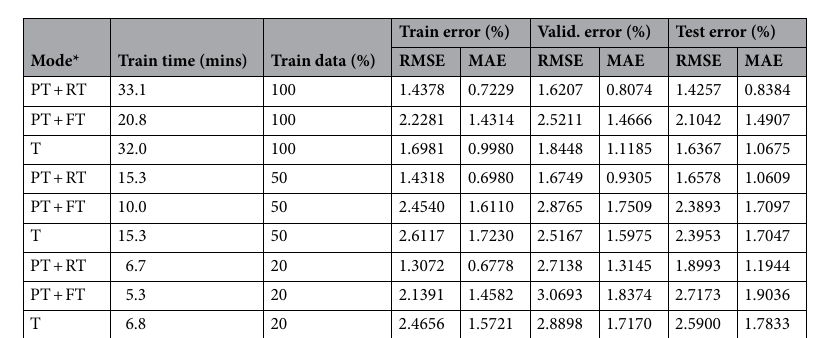
Table 3. The influence of pre-training on the training time, training data amount, and cross-dataset generalization. * PT Pre-training, RT Re-training, FT Fine-tuning, T Training.